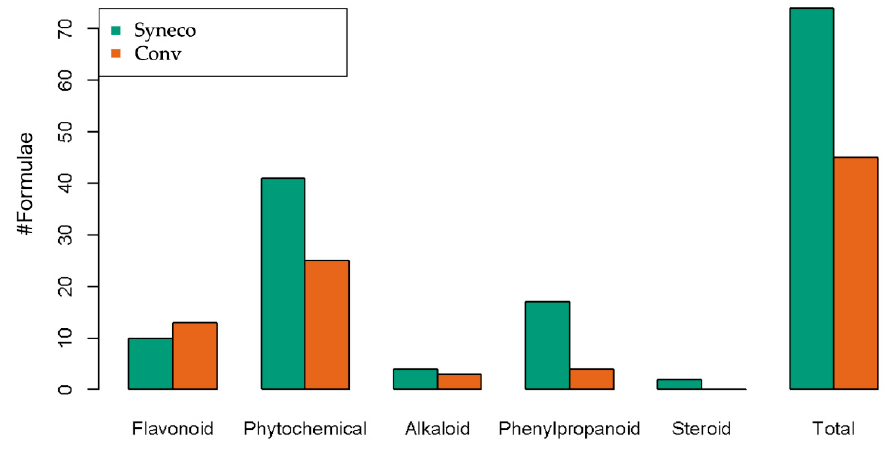
Figure 5. Graphical representation of Table 2. Table 3. KEGG PATHWAY compound classification. The numbers of different chemical formulae (# Formulae) associated with the Syneco- and Conv-distinctive loadings for each category of chemical ontology in KEGG PATHWAY hierarchy were shown. The pathway related to microbial metabolism is typed in red. See the Supplementary Materials Files S6, S7, S9 and S10 for more details. Culture Condition